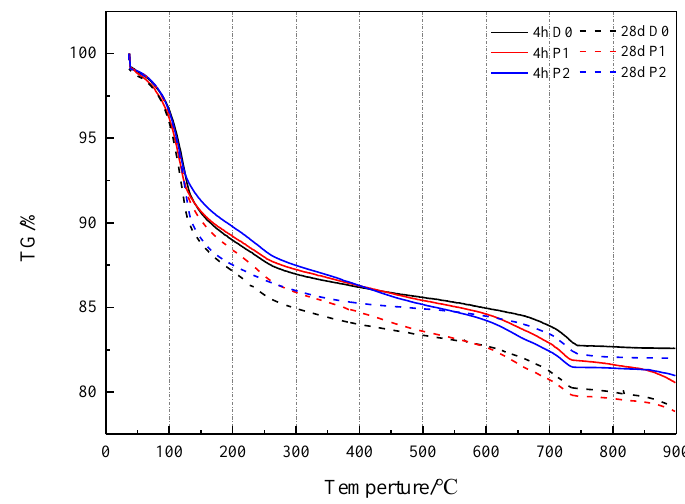
Figure 12. TG curves of composite cement in N 2 atmosphere. Table 3. Amount of ettringite (wt. %).